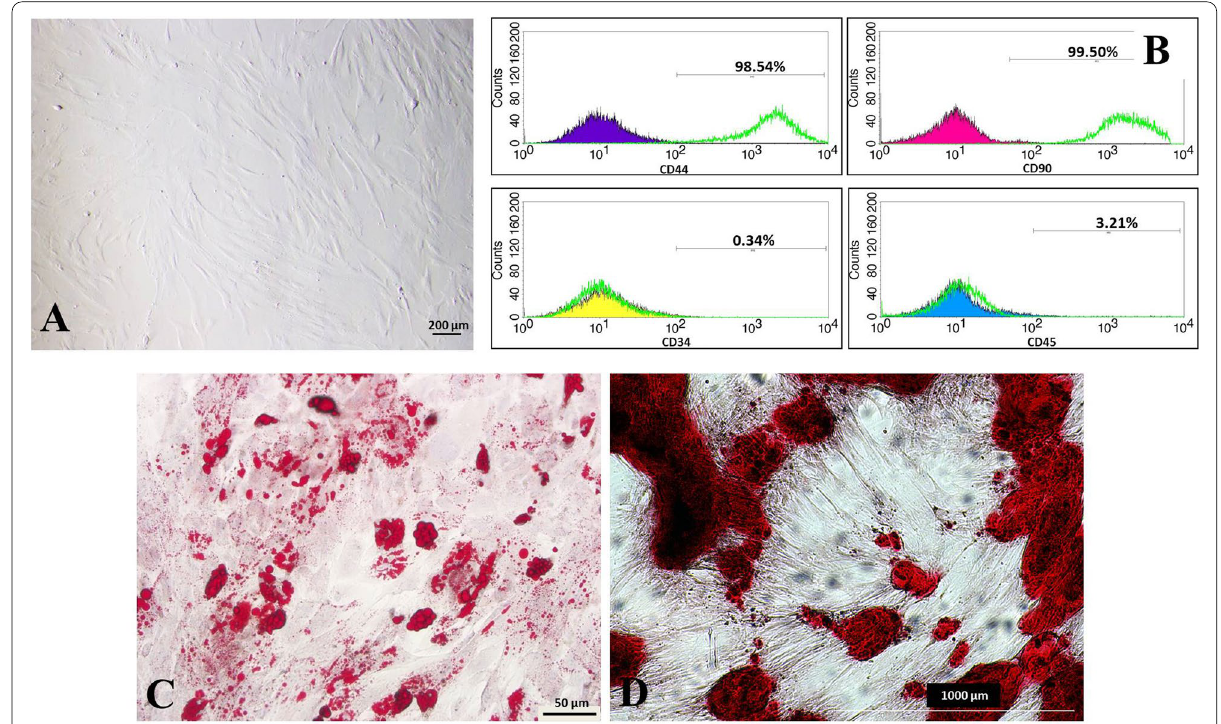
Fig. 2 Characterization results of mesenchymal stem cells. A Mesenchymal stem cells with spindle‑ and star‑shaped morphology. B Immunophenotypic characterization of umbilical cord‑derived MSCs. C Adipogenic differentiation of MSCs at the end of the 3rd week, showing lipid droplets, Oil Red O. D Osteogenic differentiation of MSCs at the end of the 3rd week, showing calcium mineralization, Alizarin